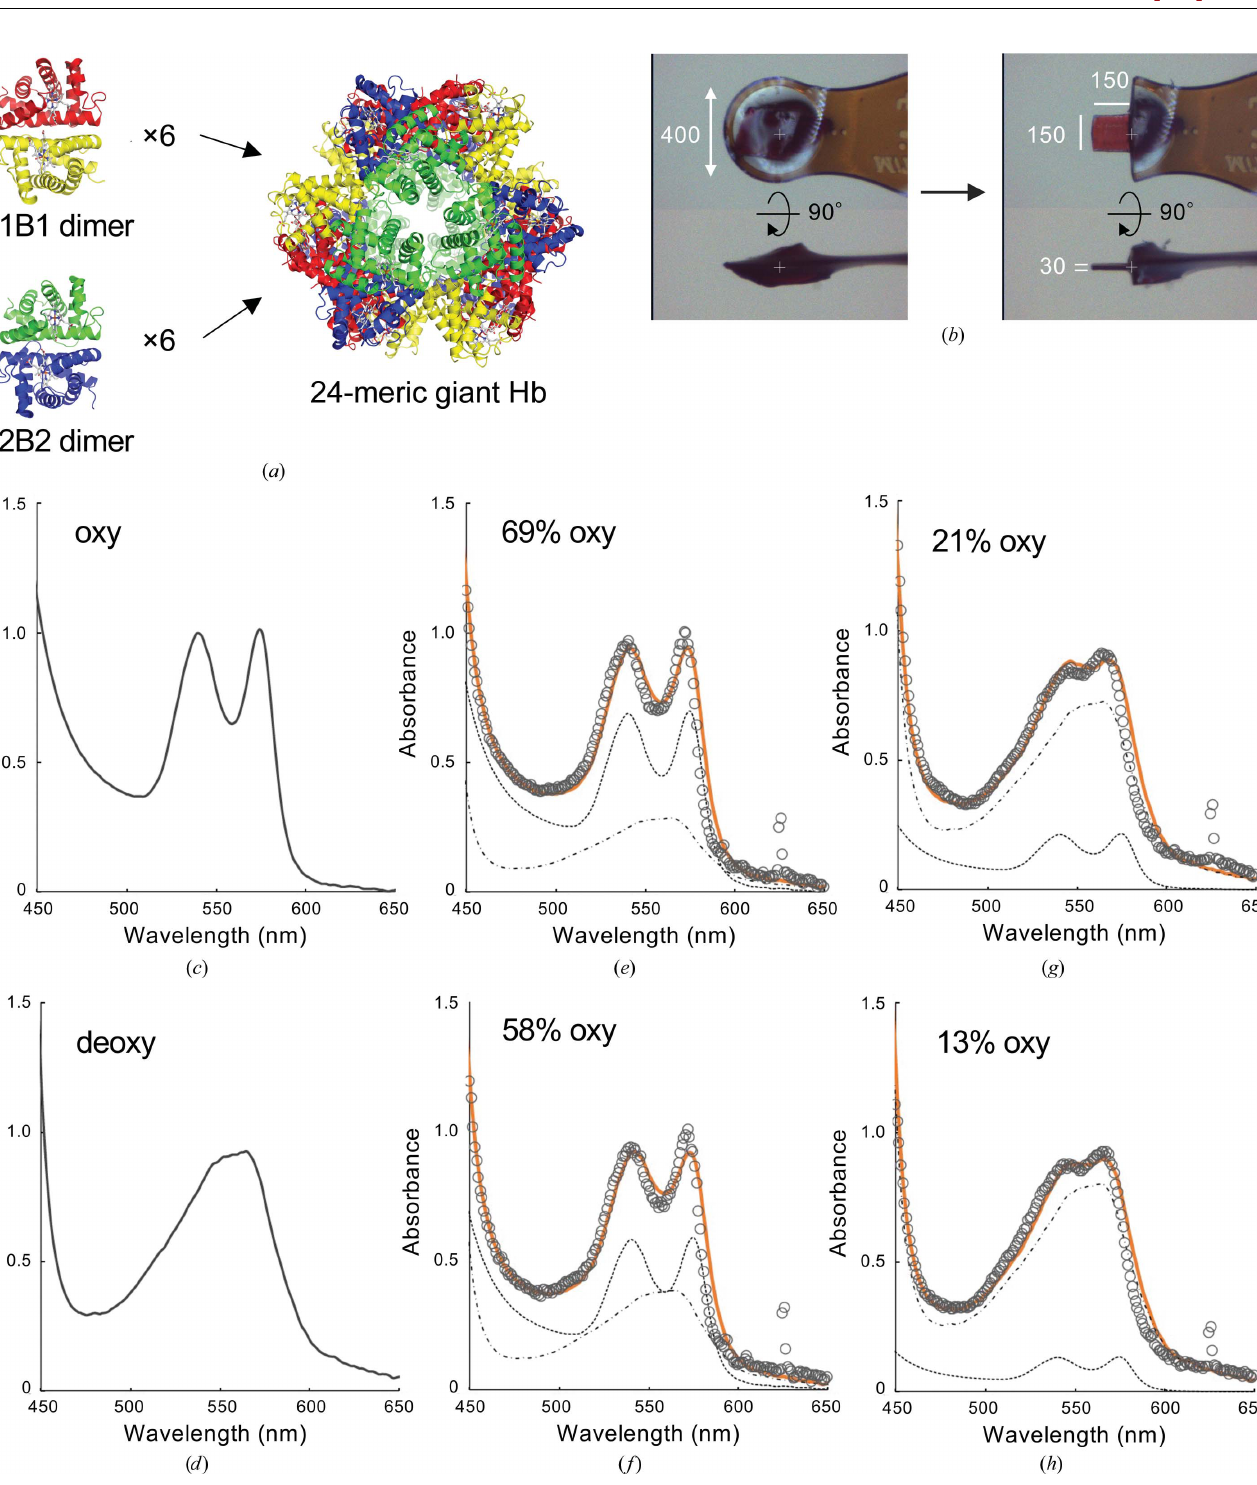
Figure 1 Determination of the oxygen saturation fraction of the crystals. ( a ) Ribbon diagram of Oli Hb. The A1, A2, B1 and B2 subunits are shown in red, green, yellow and blue, respectively. The A1 and B1 subunits form a dimer subassembly, and the A2 and B2 subunits form a similar dimer subassembly. Six A1B1 dimers and six A2B2 dimers form a spherical 24-mer assembly as a biological unit that is directly dissolved in the blood of the worm. ( b ) Crystal processing via ultraviolet laser. The image on the left is the crystal before processing, mounted in the cryo-stream. The image on the right is the crystal after processing. The values by the white lines are lengths in m m. ( c , d ) Reference absorption spectra of the oxy and deoxy forms obtained for Oli Hb in solution are shown as solid black lines. ( e – h ) The black circles are the absorptions measured from the processed crystals using a microspectrophotometer, and the orange lines are the fits calculated by a least-squares fit of the observed absorption spectrum to a linear combination of the oxy and deoxy reference spectra. The component reference spectra are shown as black dashed lines. Peaks around 630 nm are derived from the emission lines of the Hg–Xe